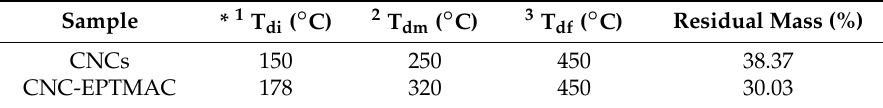
Table 2. Decomposition temperature and residual mass of modified and unmodified CNC.